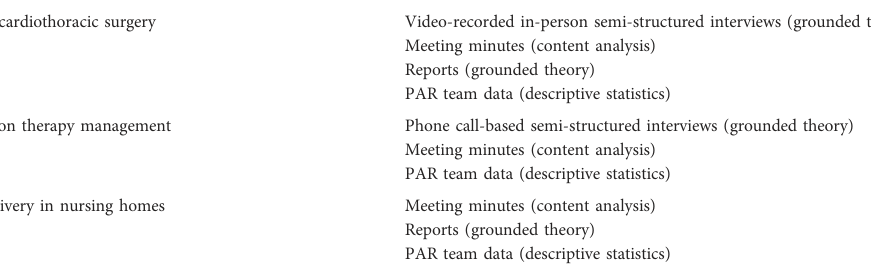
TABLE 2 List of pilot initiatives and respective data collection and analysis plan. Pilot